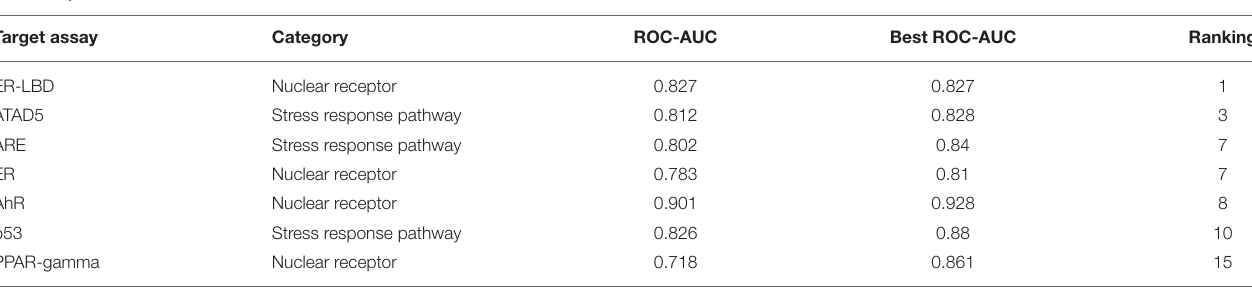
TABLE 1 | ROC–AUC values of the RF